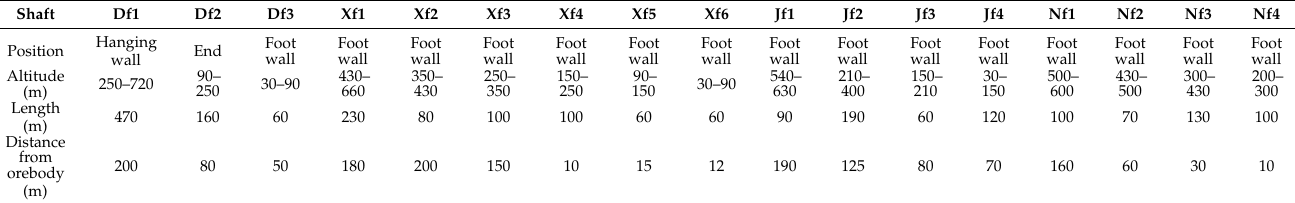
Table 1. Information of shafts.